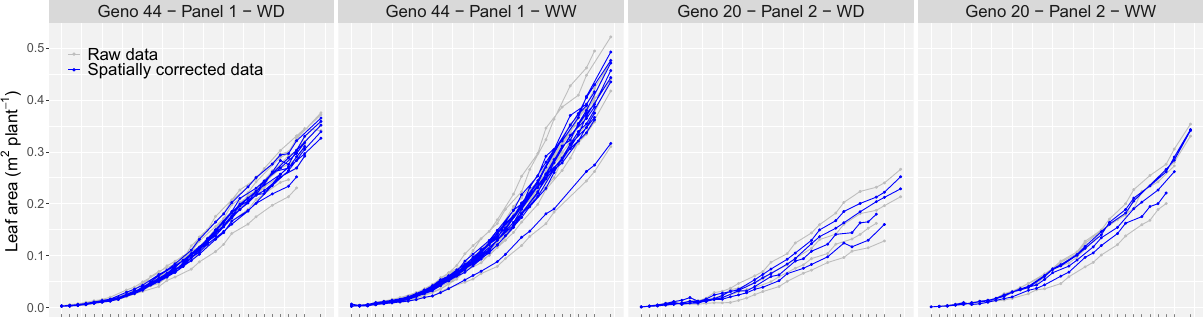
Figure 3. Results of the first stage of analysis for the PhenoArch platform: Evolution over time of the raw (grey lines) and spatially corrected (blue lines) leaf area for the plants (replicates) of two genotypes, one per panel, under the two water regimes (as illustration). WD stands for water deficit and WW for well Second stage results: PhenoArch platform. The three-level nested hierarchical growth model in Eq. (3) was fitted to the spatially corrected leaf area. We used cubic B-spline basis of dimension 13 to represent f p , f pg and f pgi (i.e., b pop = b gen = b plant = 13 ). Under this configuration, the mixed model in Eq. (5) has 52,992 observations (there are missing values), 23,920 regression coefficients (both fixed and random) and 11 variance components. Esti- mation took approximately 9 min. Computations were performed in (64-bit) R 4.1.0, and a 2.40GHz × 4 Intel (cid:31) Core TM i7 processor computer with 15.6 GB of RAM and Ubuntu 16.04 LTS OS. Estimates at the three levels of the hierarchy were obtained: (1) population growth curves ( ˆ f p ), (2) genotype- specific deviations ( ˆ f pg ) and respective growth curves ( ˆ f p + ˆ f p ), and (3) plant-specific deviations ( ˆ f pgi ) and g + ˆ f pgi ). Note that the four populations (panel by water regime combination) respective growth curves ( ˆ f p + ˆ f p g show a different growth pattern. Plants in water deficit show a lower growth compared to well watered plants for both panels (Fig. 4a). Genotype-specific deviations from their estimated population mean are shown in Fig. 4b where positive and negative deviations refer, respectively, to better and worse genotypic performance compared to the mean population. As expected, the magnitude of the deviations (and, thus, the differences among genotypes performance) increases with time. Also, genotypes from Panel 1 show the largest genetic vari- ation under both water regimes. This is in concordance with the spatially corrected data (grey lines in Fig. 4a). The genotype-by-water regime interaction is illustrated for two genotypes per Panel in Fig. 4c. When compared to the average performance of the genotypes in the Panel, genotype 44 in Panel 1 and genotype 20 in Panel 2 behave similarly under both water regimes (they depict similar deviations under both treatments). In contrast, genotype 43 in Panel 1 presents a better performance under WD regime, while genotype 03 in Panel 2 displays a better performance under WW regime. Finally, the model is able to successfully recover the evolution over time of the spatially corrected leaf area (Fig. 4d, grey lines), while appropriately handling the missing data, as illustrated with the plant-specific growth curves (Fig. 4d, dotted blue lines) of two genotypes (see also results for the populations means in Fig. 4a). Additionally, genotype-specific growth curves (Fig. 4d, orange lines) seem to properly summarise/describe the behaviour of the plant curves. To asses the relative accuracy of our model in + ˆ f pgi , we computed the mean absolute percentage error predicting the plant-specific growth curves, i.e. ˆ f p + ˆ f p g (MAPE). For this data, the MAPE value was 2.9% , indicating a good performance. FIP platform (ETH Zürich).